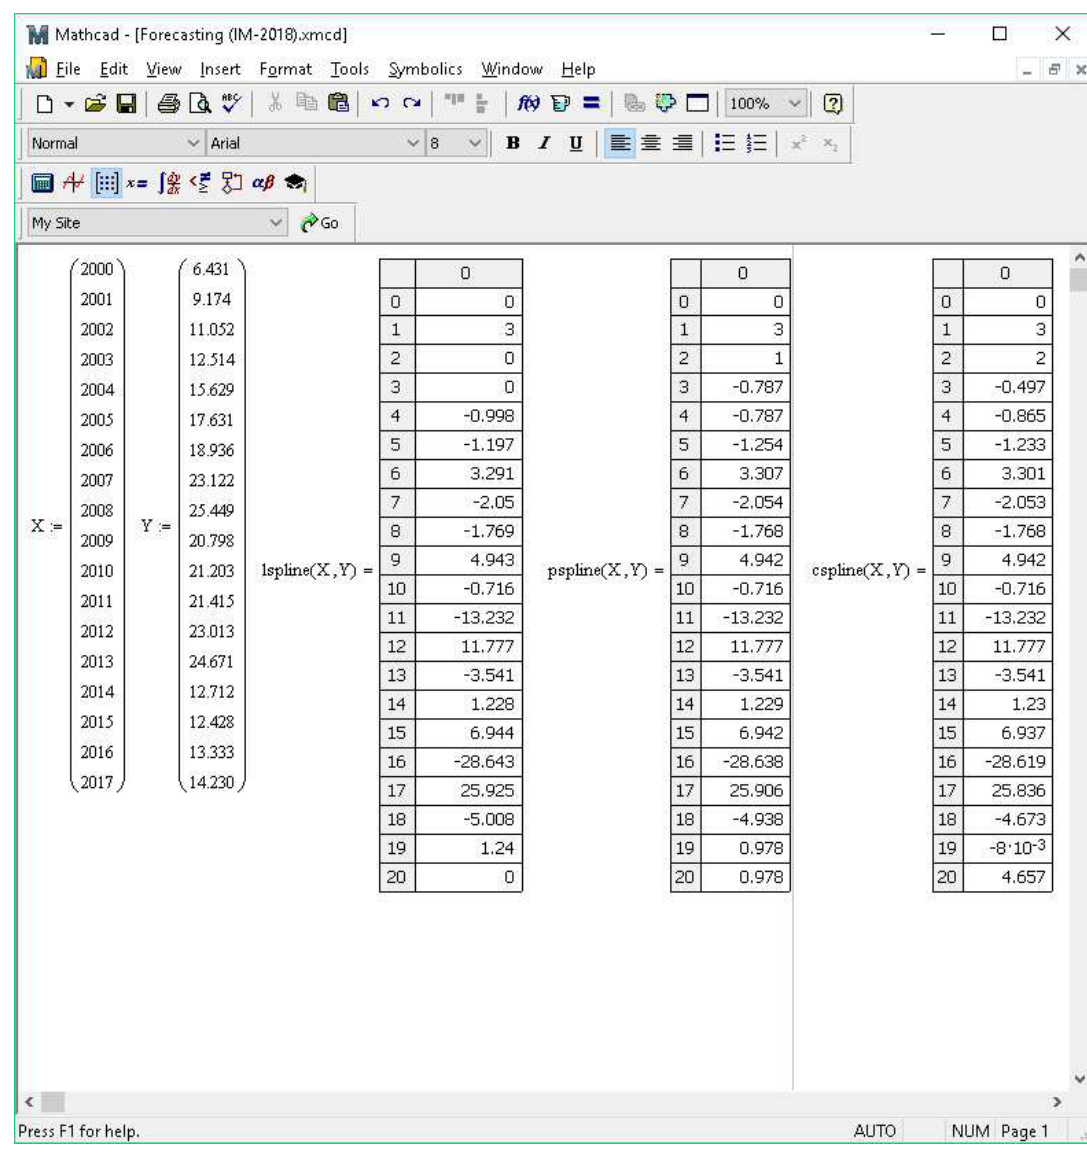
Figure A5. Creating the matrices of data in